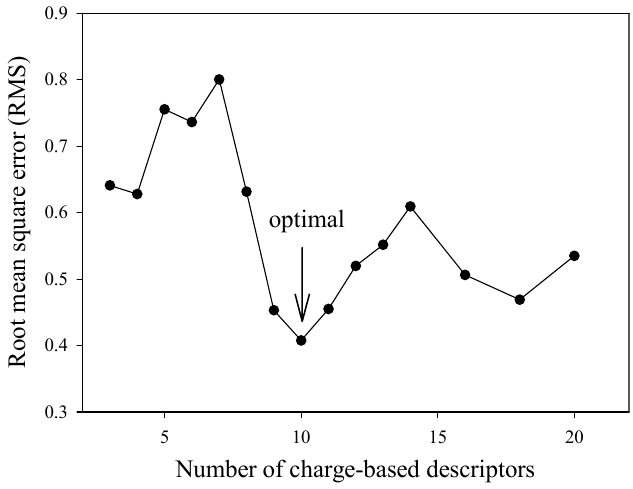
Figure 1. Plot of RMS as a function of the number of TAE molecular descriptors.